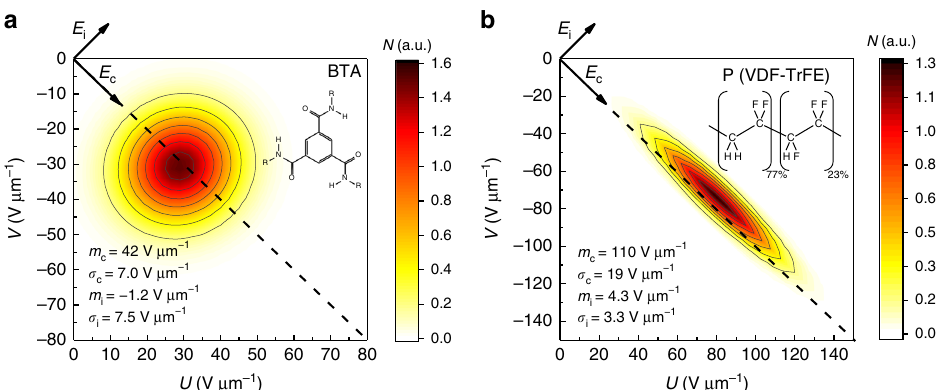
Fig. 3 Fitted normalized Preisach distribution. a BTA at 55 °C and b P(VDF-TrFE) at room temperature. The rotated coordinate system is shown, and the dashed line indicates U = − V . The four fi t parameters are given in each